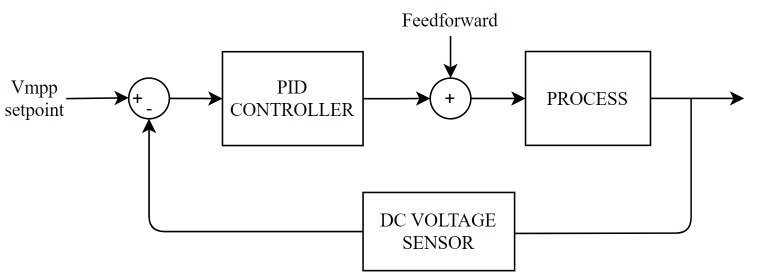
Figure 4. PID diagram with feedforward